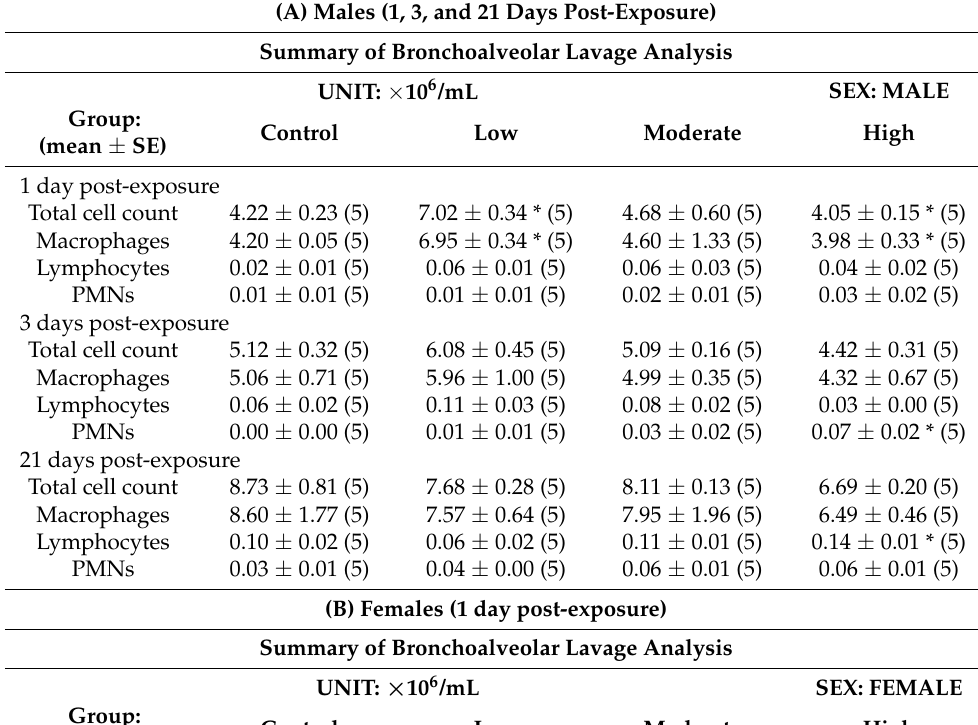
(B) Females (1 day post-exposure)